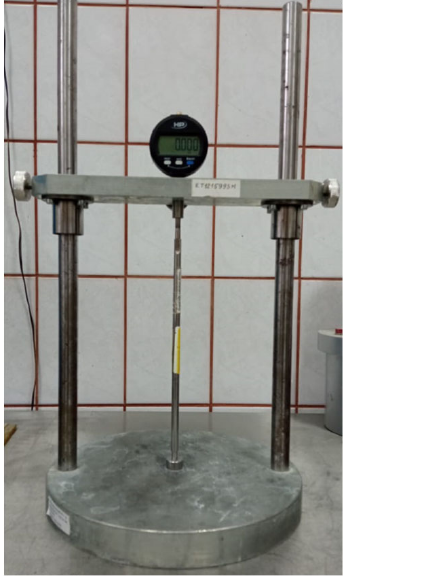
Figure 2. Images of prism length measurement after 90 days; ( a ) setting zero; ( b ) length measurement.